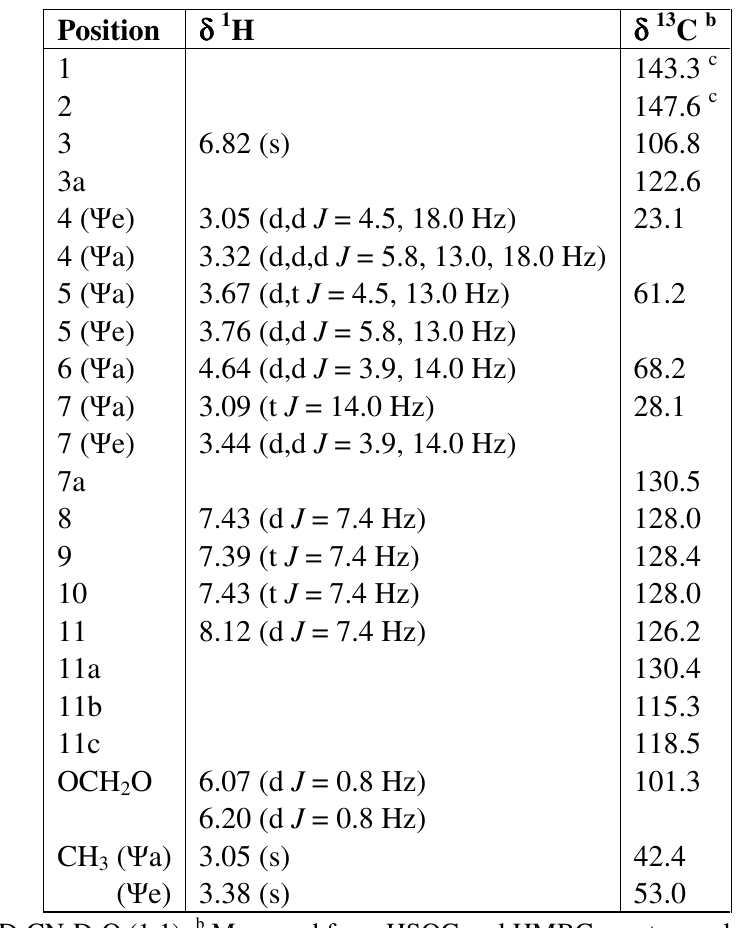
Table 1. 1 H- and 13 C-NMR data for roemrefidine ( 3 ) a